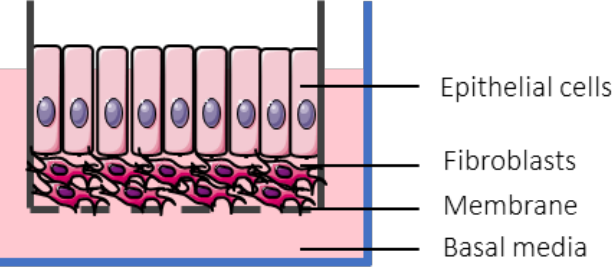
Figure 7. EpiIntestinal full thickness tissue cultured at the air-liquid interface. Adopted with permission from [159], Oxford University Press, 2018.